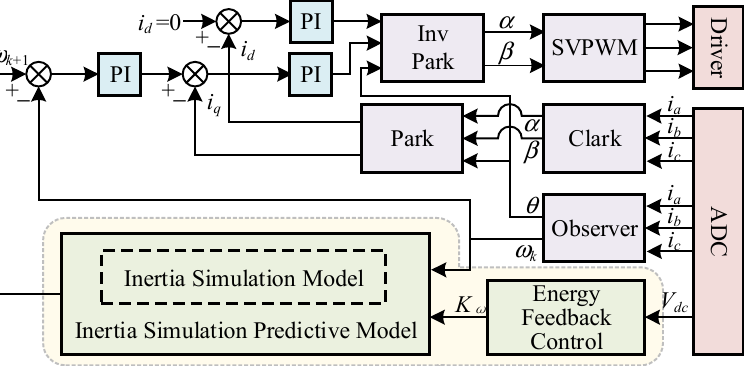
Figure 6. The complete block diagram of the load simulation algorithm.